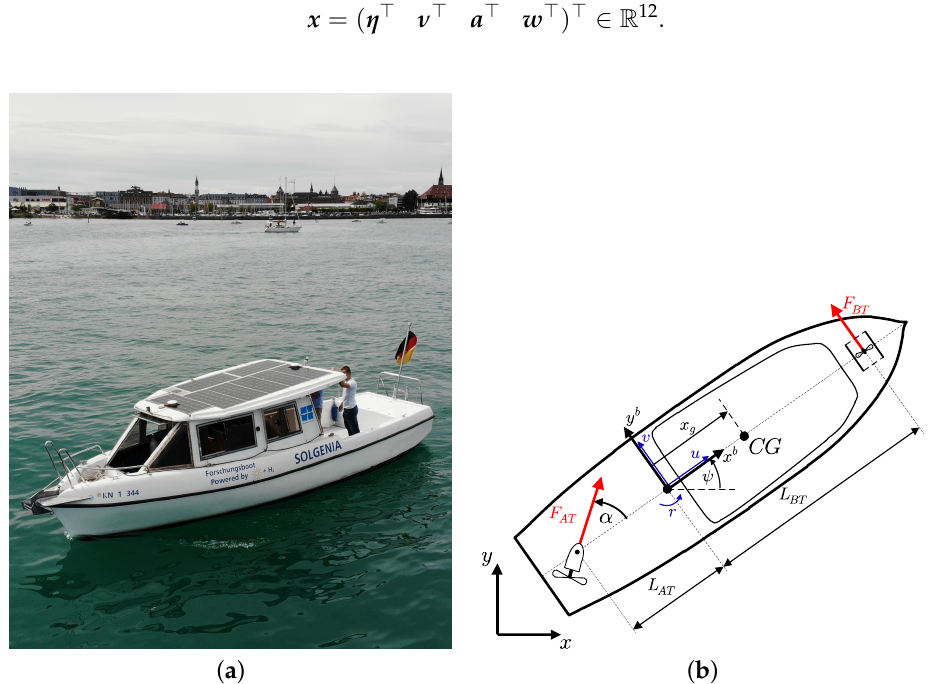
Figure 2. Photography and technical drawing of the research vessel Solgenia . ( a ) photography of the research vessel Solgenia on Lake Constance in front of the Constance harbor; ( b ) technical drawing of the research vessel Solgenia with local and body-fixed coordinate systems, geometrical parameters and thruster